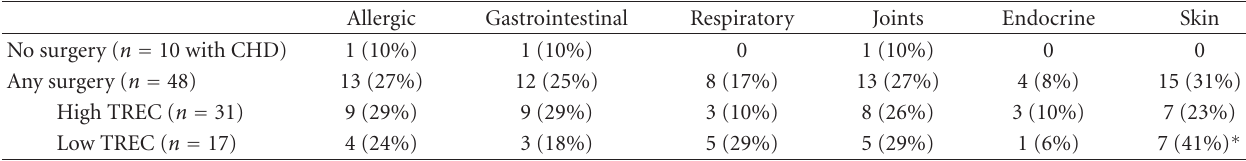
Figure 3: Quantification of Tregs. Percent and absolute number of CD4+/CD25+/Foxp3+ Tregs are displayed. Groups were compared using Wilcoxon rank sum with no di ff erences found based on level of thymopoiesis and history of surgery. Table 3: Symptoms reported by organ or system (number of